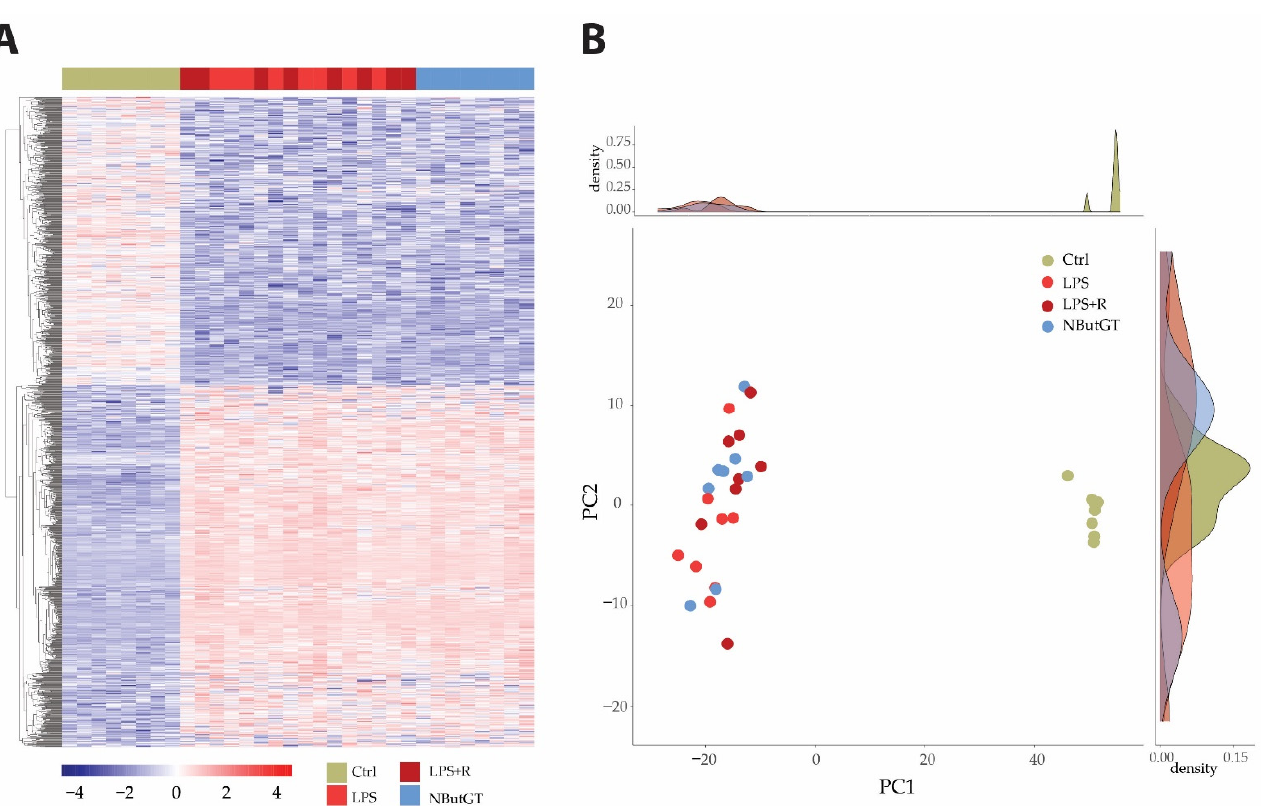
Figure 2. Heatmap and principal component analysis. Transcriptome analyses were made from whole heart of rats injected with saline (CTRL), LPS (LPS) treated with either fluidotherapy (LPS + R) or NButGT (NButGT), and this allowed the identification of 13730 genes. Differentially expressed genes (DEGs) were selected by their fold change of expression between 2 conditions log2Ratio(Fold change) >1 or log2Ratio(Fold change)> − 1 and an adjusted p value < 0.05 using the R package “Deseq2”. Heatmap visualization ( A ) of the 1483 DEGs with the comparison Ctrl vs. LPS and the 1 DEG with the comparison LPS vs. LPS + R showed that Ctrl and NButGT rats were well clustered but LPS and LPS + R showed no clusterization. Plotting of individuals and frequencies from Principal Component Analysis (PCA) of DGEseq data using R statistical language showed Ctrl rats clustered but no separation of LPS, LPS + R and NButGT individuals ( B ). After 3 ′ SRP analysis of heart transcriptome, a total of 1483 genes of the 13730 detected genes matched our selection criteria (Log2 (fold change) < − 1 or >1 and p-adjusted <0.05). Differentially expressed genes’ (DEGs) visualization with heatmap showed a good clusterization of samples within groups (Figure 3A). Gene clusterization showed two main clusters of DEGs in either the CTRL or LPS groups. These DEGs were retrieved in the volcano plot representation that showed 828 (55%) genes were overexpressed in the LPS group, while 655 (45%) genes were overexpressed in the CTRL group (Figure 3B).